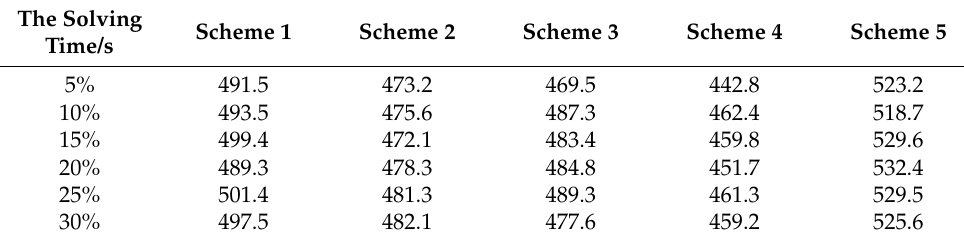
Figure 9. Optimization results of five schemes under different prediction errors. Table 2. The solving time of five schemes under different prediction errors.